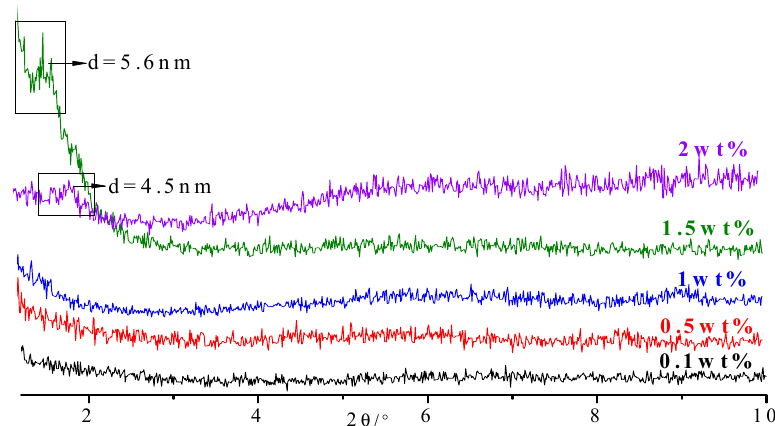
Figure 8. XRD patterns of the sericite/epoxy resin with different amounts of intercalated sericite added.